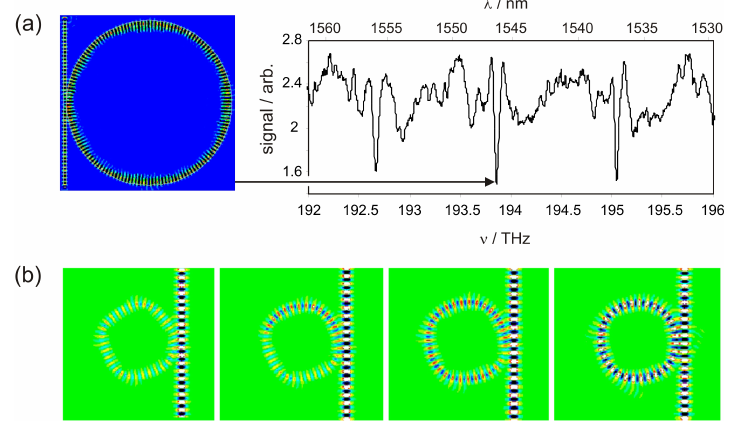
Figure 2. 2D finite difference time domain (FDTD) simulations of WGMs in optical fibres. Panel (a) shows part of the simulated spectrum for a 50 micron sensor fibre, with the electromagnetic field for a selected mode ( m = 146, l = 1) shown inset; panel (b) illustrates the build up of the electromagnetic field in the m = 31, l = 1 WGM of a 10 micron fibre through constructive interference over